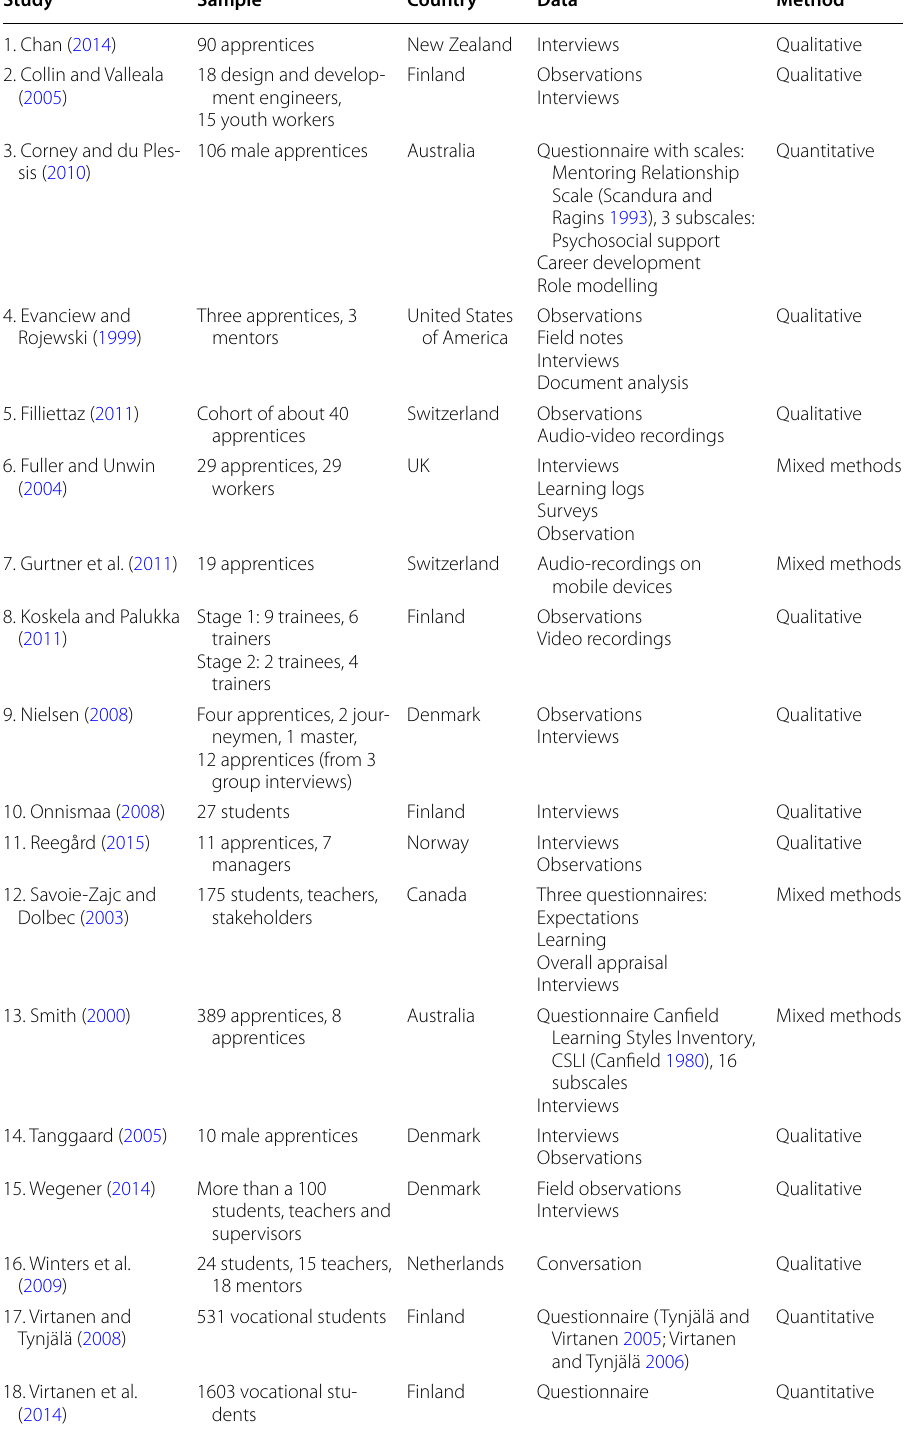
Table 1 Overview of the studies